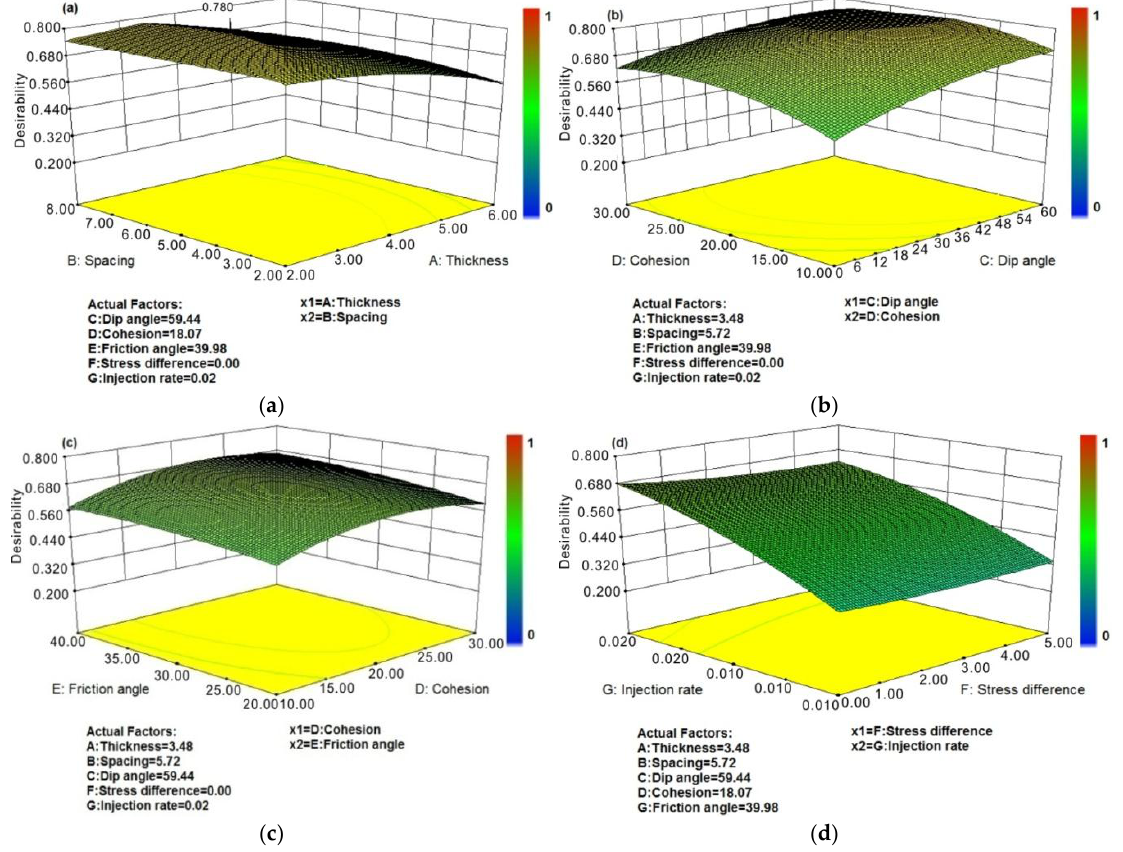
Figure 12. The 3D response surfaces for SRA and SLA with optimal project: ( a ) plots the influence of factor A and B on the desirability of solutions; ( b ) plots the influence of factor C and D on the desirability of solutions; ( c ) plots the influence of factor D and E on the desirability of solutions; and ( d ) plots the influence of factor F and G on the desirability of solutions;